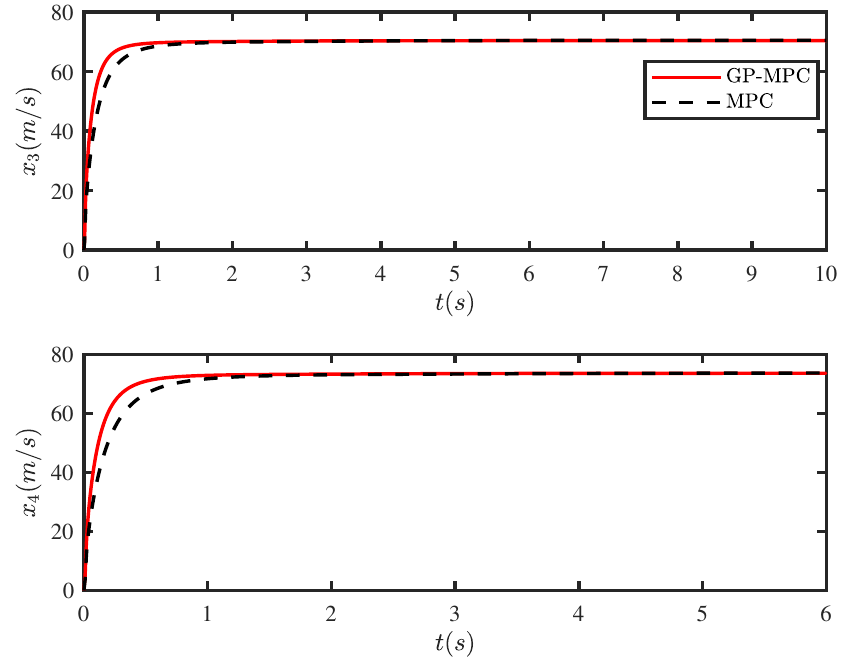
Figure 10. Pressure of hydraulic system under different control